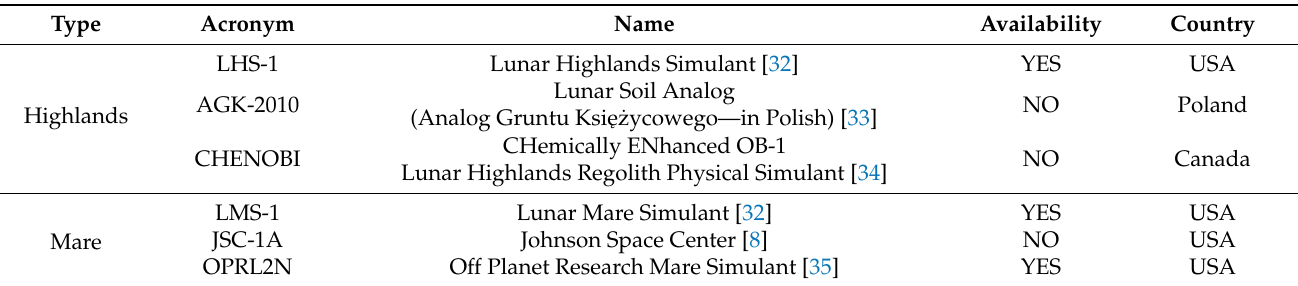
Table 1. Lunar soil simulants used in this